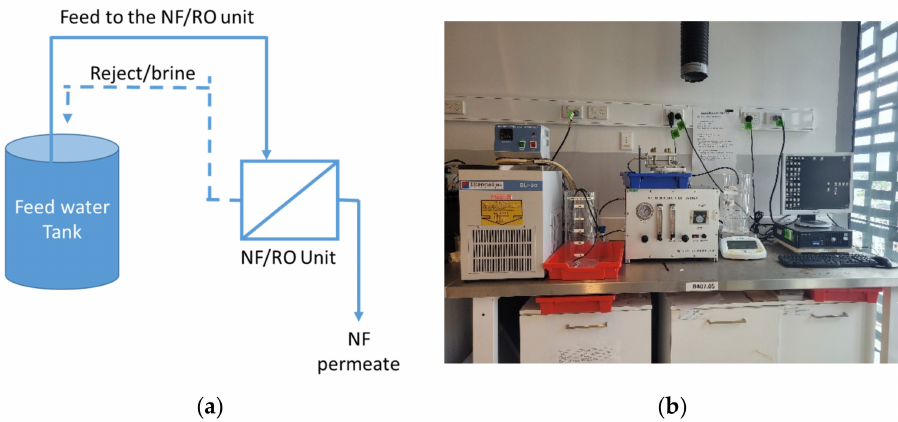
Figure 3. NF/RO membrane filtration unit: ( a ) schematic diagram; ( b ) laboratory